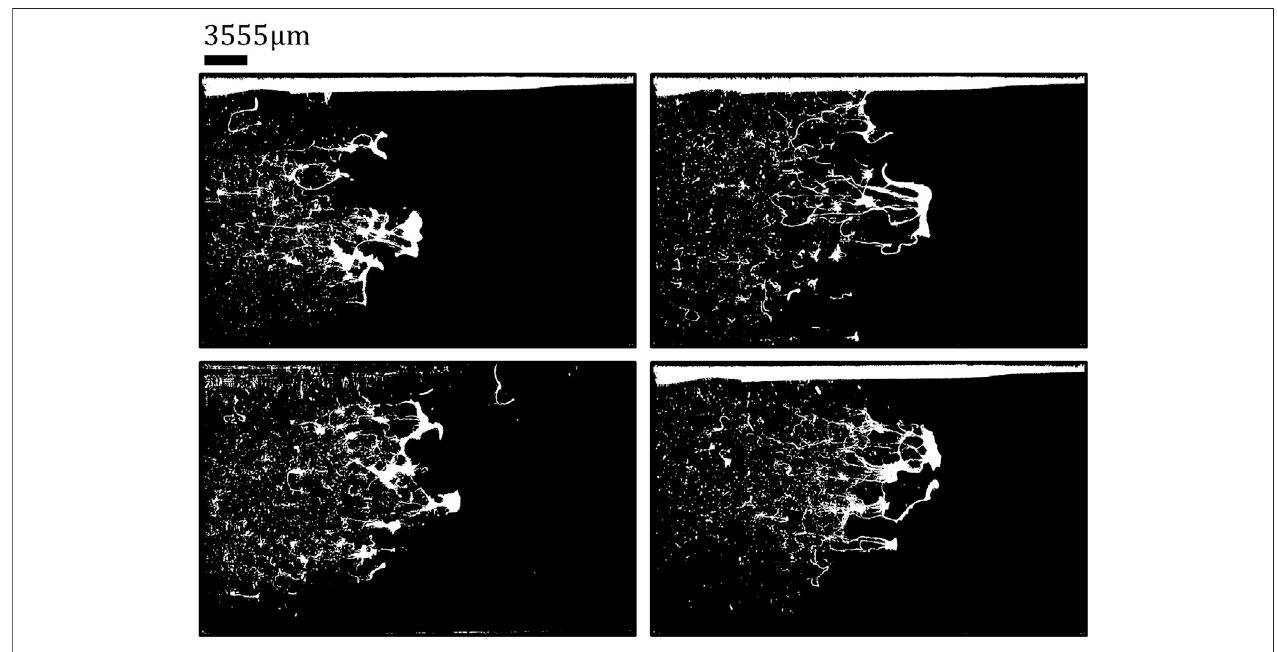
FIGURE 4 | Rough ground truth produced by the